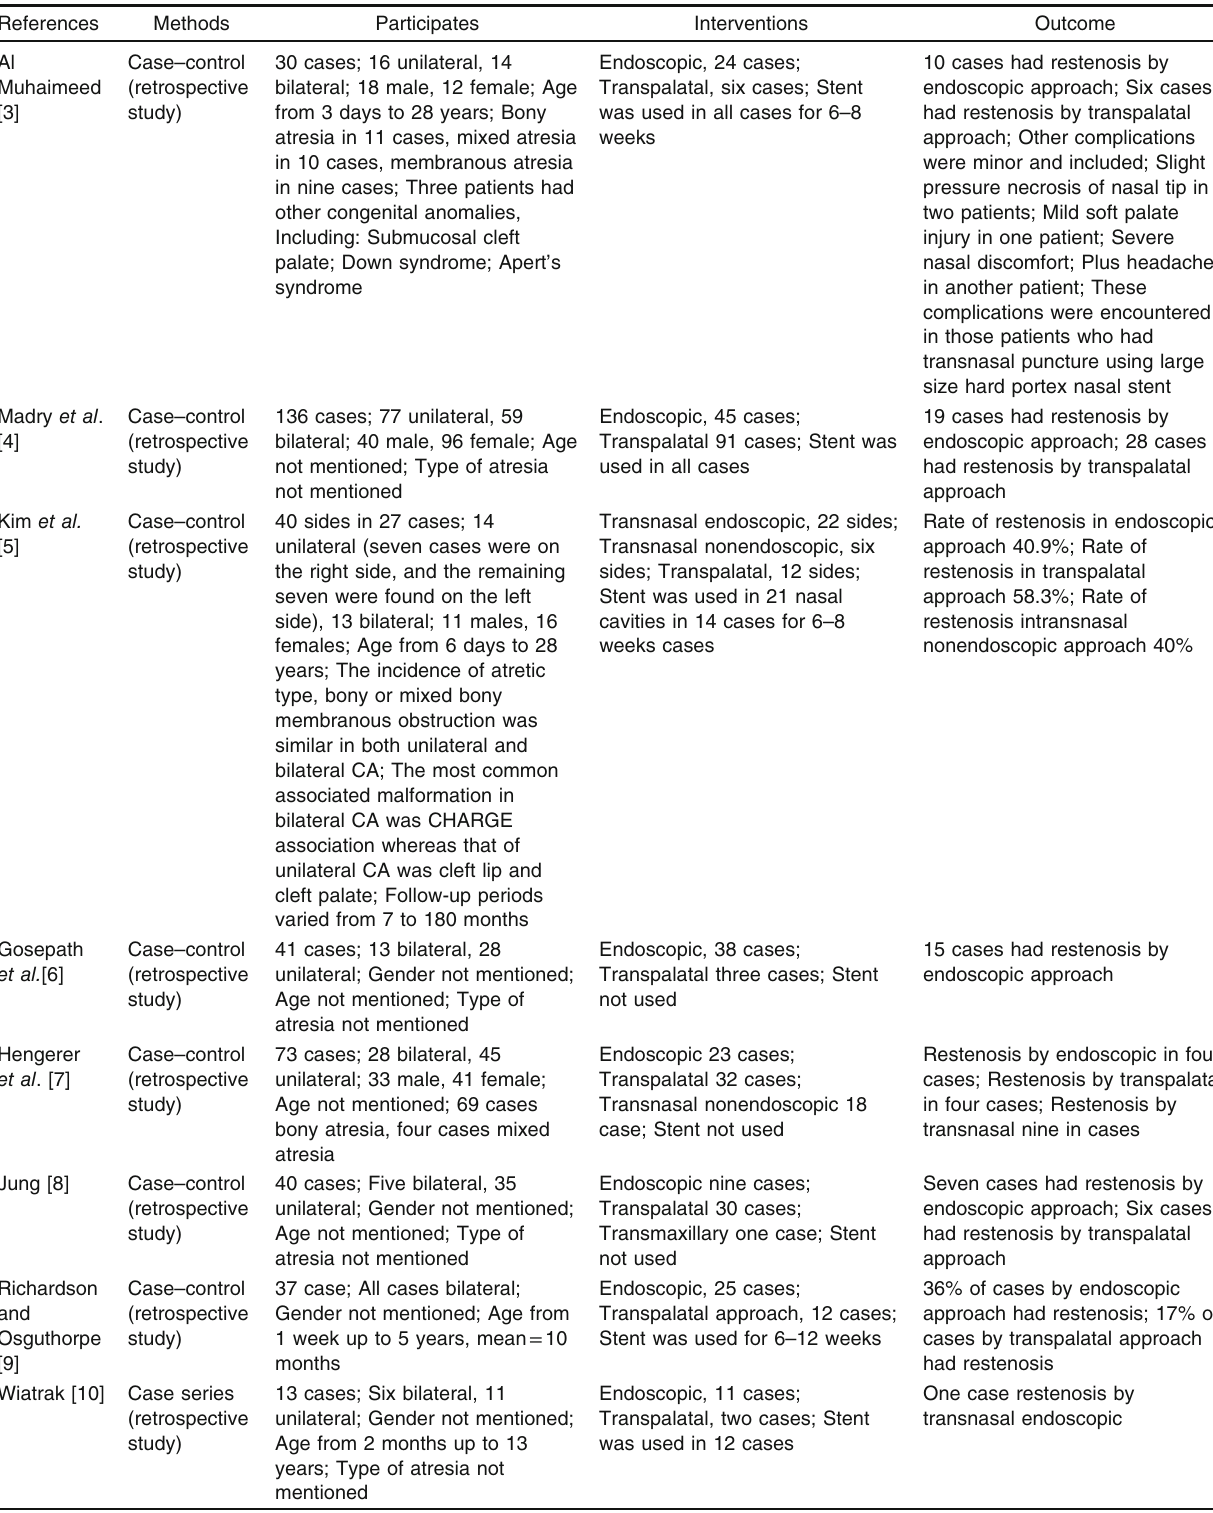
Table 2 Articles involved in comparing the endoscopic transnasal versus transpalatal repair of CA. as regard the outcome of repair of